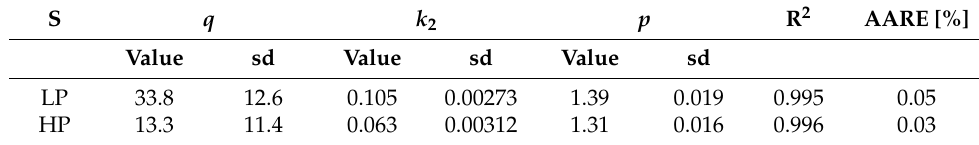
Figure 7. Log-Log plot of true strain and stress obtained with two parameter sets. The blue pentagon shows where the curve diverges from linearity. Table 4. Fitting parameters of Voce model. The R 2 and AARE indicates a very good